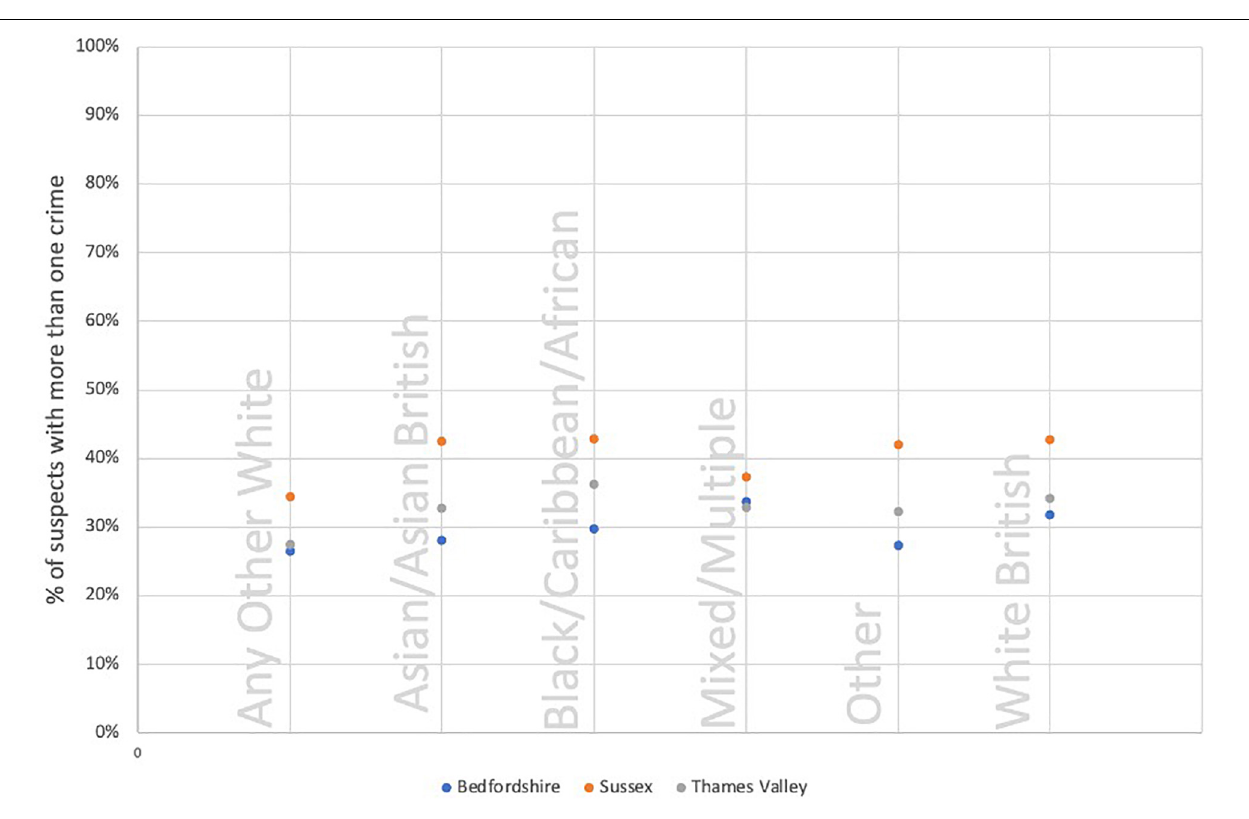
consistently among the lowest for proportion of cases solved.